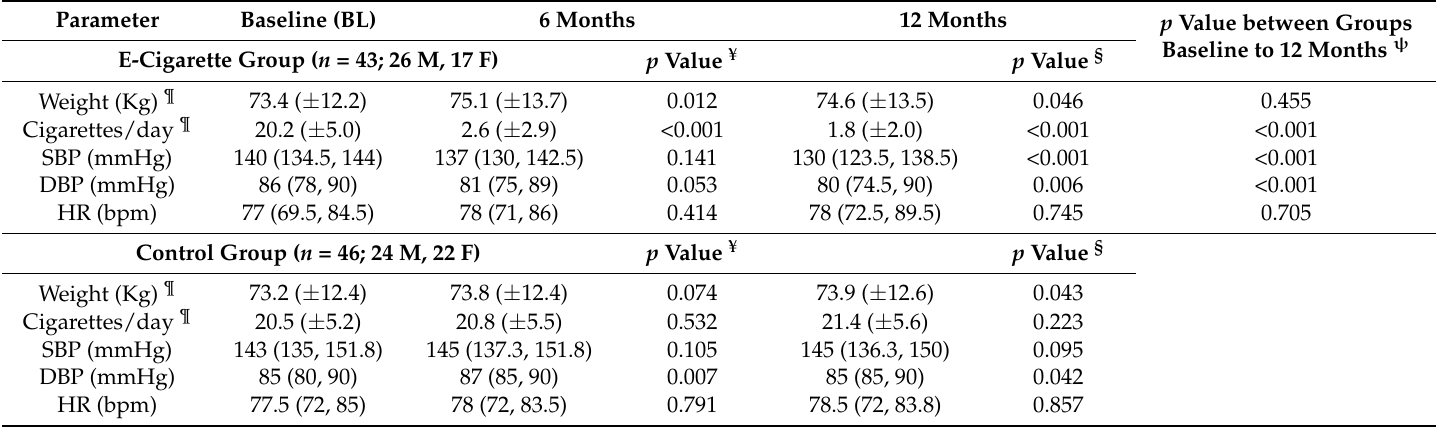
Table 2. Parameter measurements at baseline, 6- and 12-months for both